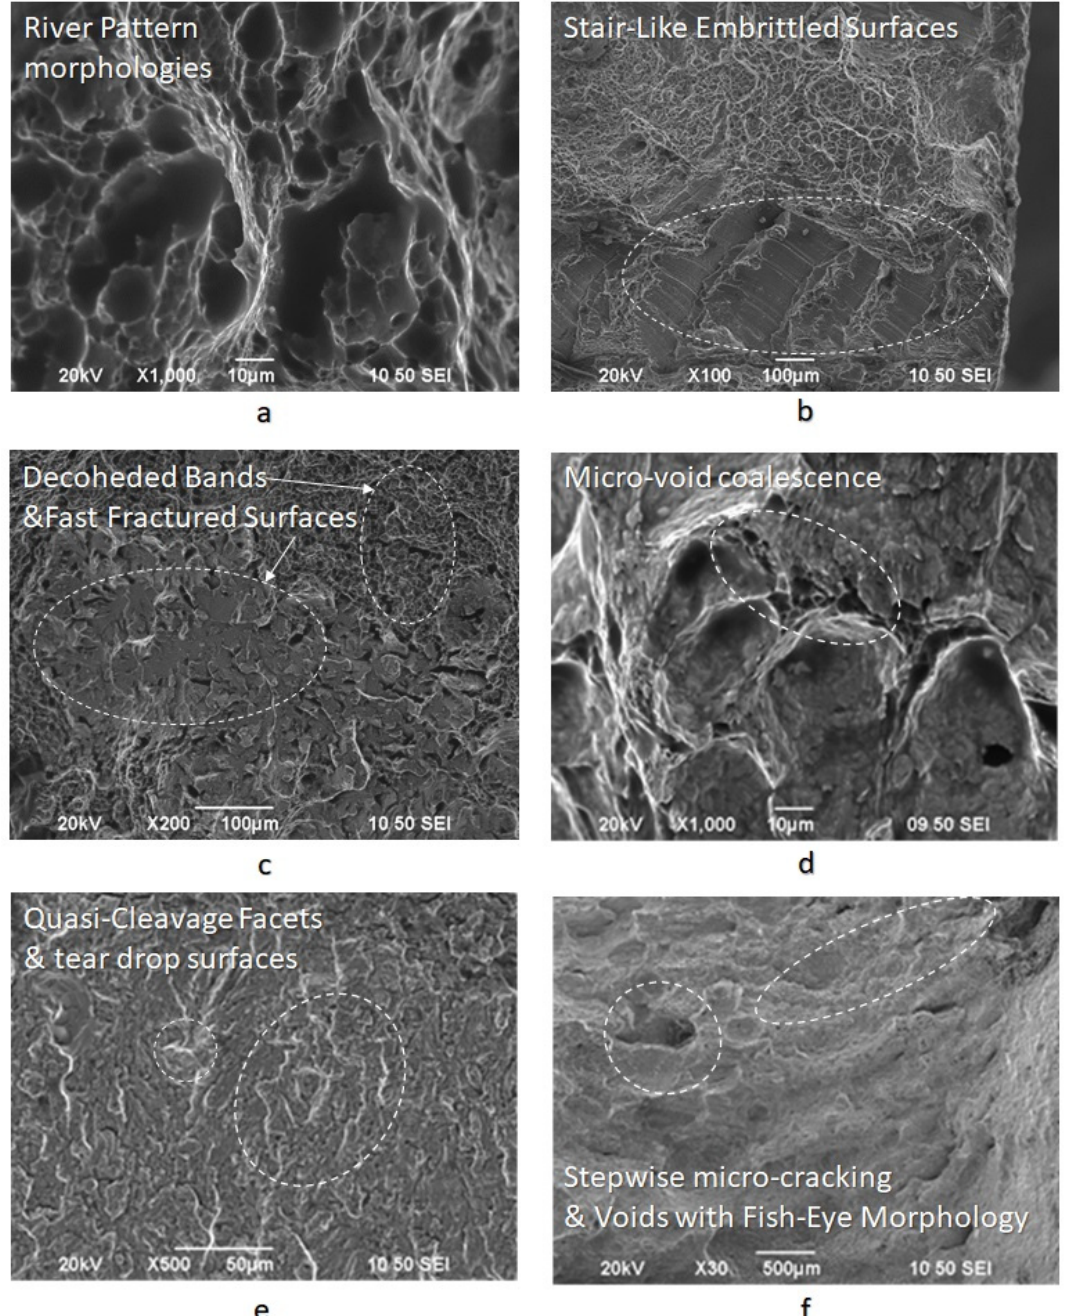
Figure 18. Fractured surfaces after CTOD testing under in situ hydrogen cathodic charging condition at 20 mA/cm 2 , ( a ) river pattern morphologies, ( b ) stair-like embrittled surfaces, ( c ) decoded bands and fracture surfaces, ( d ) micro-void coalescence effect, ( e ) quasi-cleavage facets and teardrop surfaces and ( f ) voids with fish eye morphology and stepwise micro-cracking.